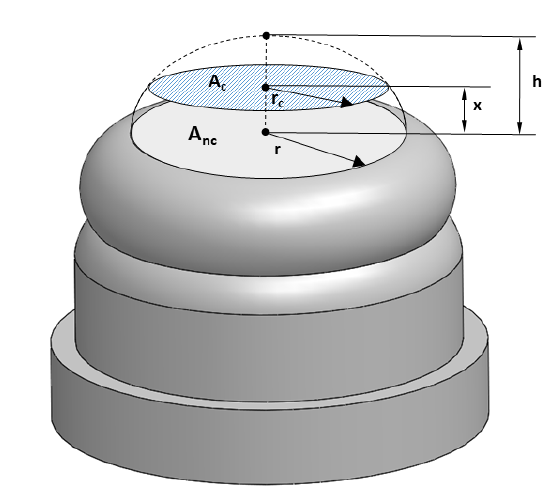
Figure 12. Graphic description of the contact area and the non-contact area, where r is the actual radius of the soft actuator, r c is the radius of the contact area, x is the distance between the actuator and the object and h is the relative longitudinal distance between the soft actuator at rest and its maximum displacement at a given